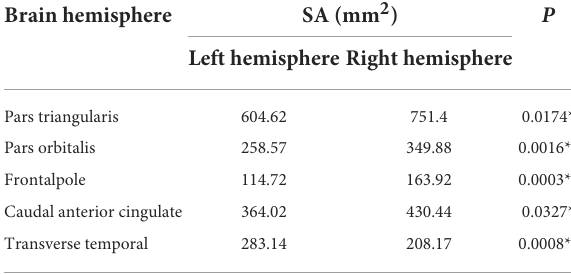
TABLE 3 Brain cortical regions that show significant asymmetry in cortical thickness (CT) in the GDD group.